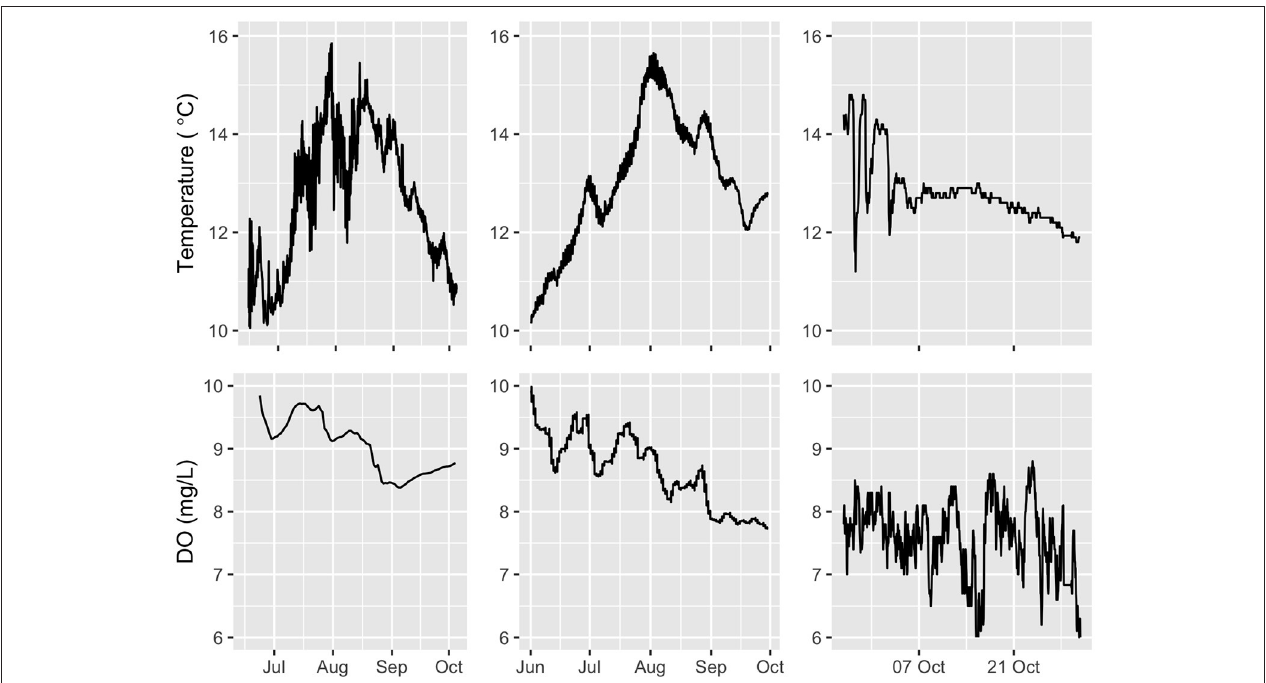
FIGURE 5 | Time series plot of temperature (top row), and DO (bottom row) reported at the three sites, NOR (left), SCO (middle), and CAN (right),